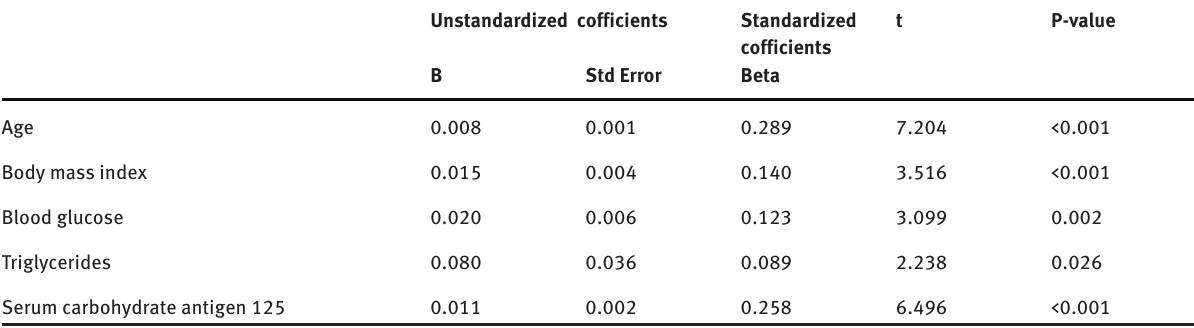
Table 4: Carotid intima-media thickness as dependent variable in multivariable linear regression analysis Unstandardized